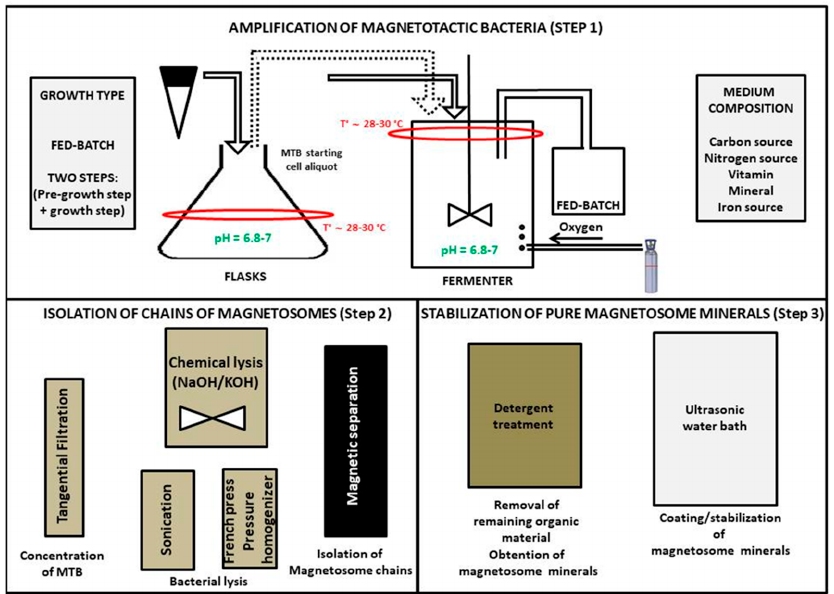
Figure 2. Schematic diagrams presenting the different steps of magnetosome production, which